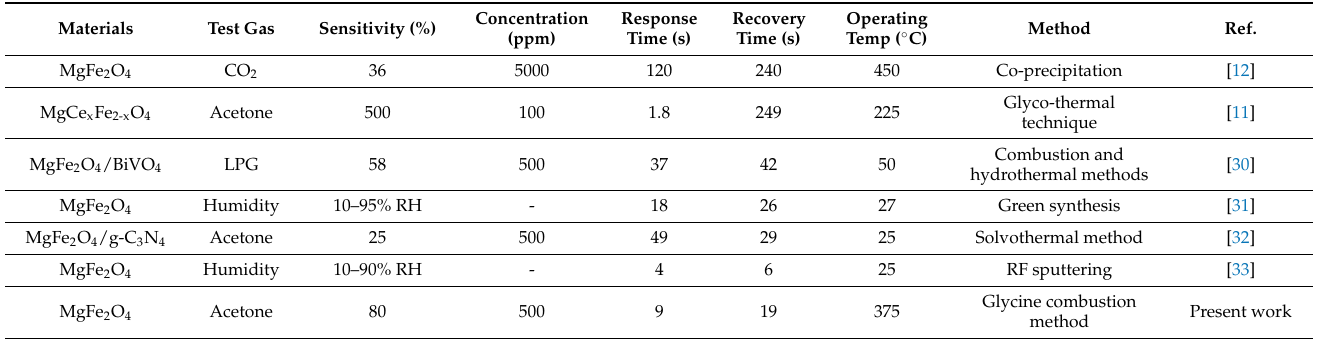
Table 4. Comparative chart of gas-sensing performance of developed MgFe 2 O 4 ferrite with state of art in the same